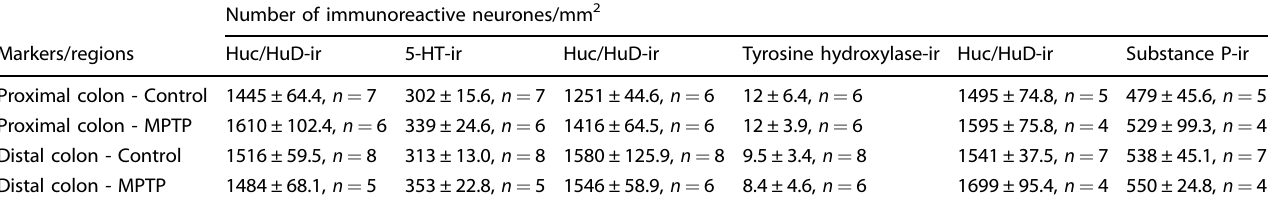
Fig. 5 Frequency and the amplitude of spontaneous contractions in isolated distal colon preparation. a Two representative traces showing spontaneous contractile response of colon preparations obtained from control (blue trace) and MPTP-treated (red trace) animals. b The frequency and c amplitude of spontaneous contraction in MPTP-treated ( n = 6) and naïve ( n = 7) animals; unpaired Student ’ s t -test. d The effect of carbachol on the change in tone of isolated distal colon in MPTP-treated ( n = 6) and naïve ( n = 8) animals); all values are mean ± SEM; Two-way repeated measure ANOVA. Table 1. The number of 5-HT-, TH- and substance P-ir cells in an area of 1 mm 2 relation to the number of Huc/HuD-ir neurons. Each value is mean ± SEM. There were no signi fi cant differences between the number of HuC/HuD-ir cells or other markers in the proximal or distal colon in either control or tissues obtained from MPTP-treated